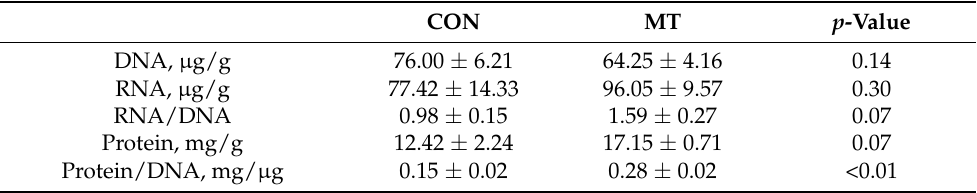
Table 2. Effects of maternal MT supplementation during gestation on placental DNA, RNA, and protein concentrations.